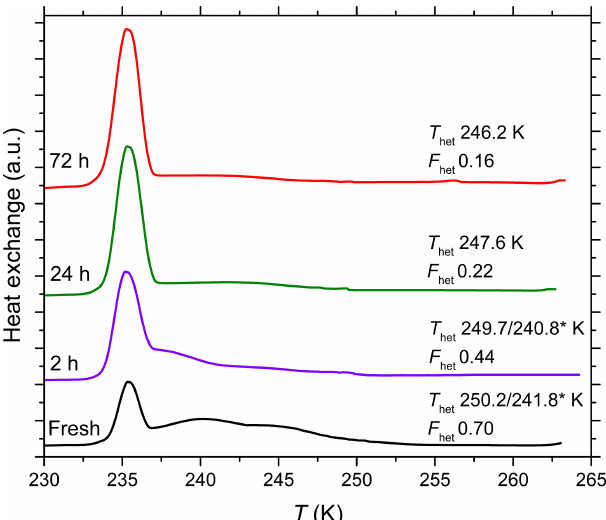
Figure A2. DSC thermograms of Kaufmann quartz taken from the supernatant of a suspension of the same quartz sample as used in Kaufmann et al. (2016) that had settled for 1h. Settling resulted in particle sizes with diameter ≤ 3µm and a suspension concentration of 8wt%–9wt% in the supernatant. In order to assess the effect of aging, emulsion freezing experiments were performed on the super- natant right after extraction as well as after 2, 24 and 72h after ex- traction and the corresponding T het and F het is reported next to each curve. All curves are normalized such that the areas under the het- erogeneous and homogeneous freezing curves sum up to the same value. The ∗ symbol represents the onset temperatures of the two shoulders of the heterogeneous freezing signal and the correspond- ing F het is calculated based on the complete freezing